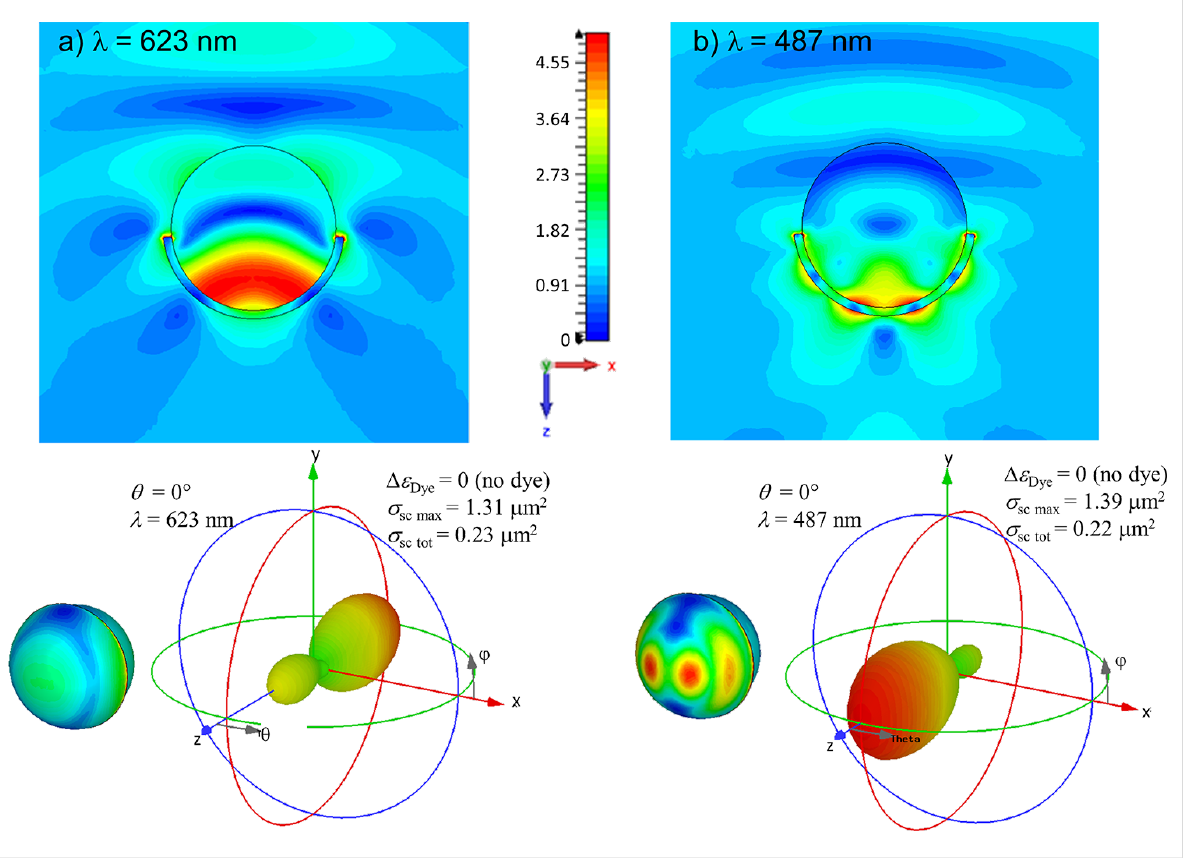
Figure 3: Mode characteristics of the two absorption maxima in Figure 2d ((0,0), i.e., sphere side illumination, h = 20 nm), at λ = 623 (a) and 487 nm (b). The upper images show the field enhancement | E |/ E 0 in the propagation–polarization x – z plane. The 3D graphs on the lower left of (a) and (b) show | E |/ E 0 in air near the surface of the semi-shell, i.e., the near-field just outside the structure. The mode at 623 nm is a “void like” dipolar mode ( l = 1), while the mode at 487 nm is a l = 2 mode. The 3D spherical plots show the differential scattering cross sections on a linear scale. The maximum of the differential and the total σ sc are given in the